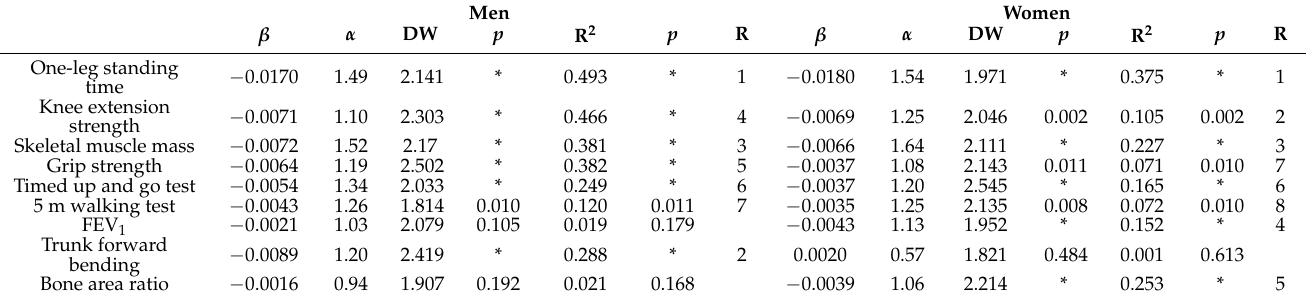
Table 3. Comparison of the rate of decline in each physical function between men and